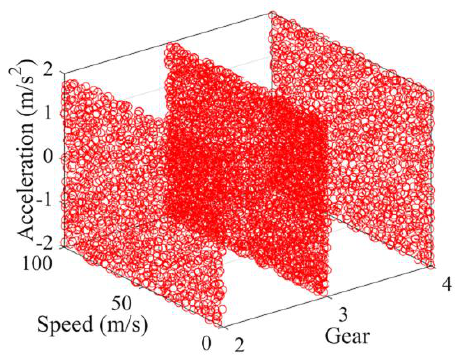
Figure 6. Opt LHD sampling diagram.